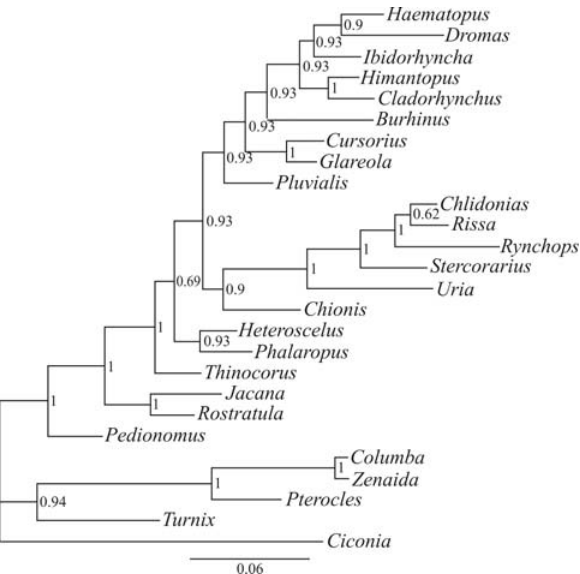
Figure 1 - Consensus Bayesian tree derived from the anatomical data set. Numbers at nodes are posterior probabilities.